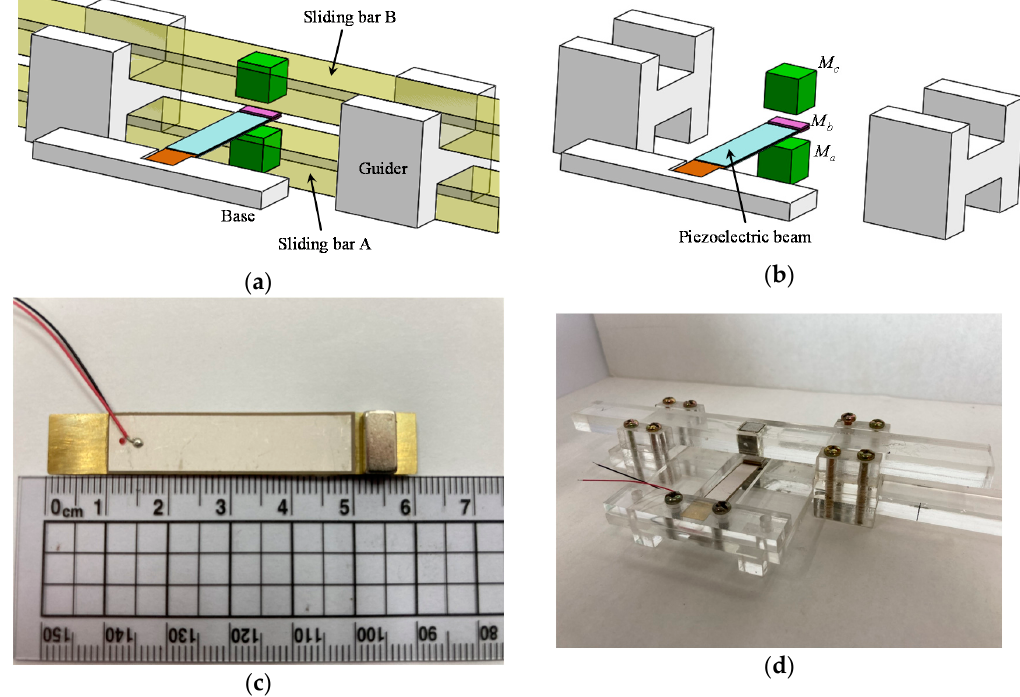
Figure 4. ( a ) The design of the PEH; ( b ) The design of the PEH with invisible slider bars; ( c ) Piezoelectric beam; ( d ) Prototype of the PEH.